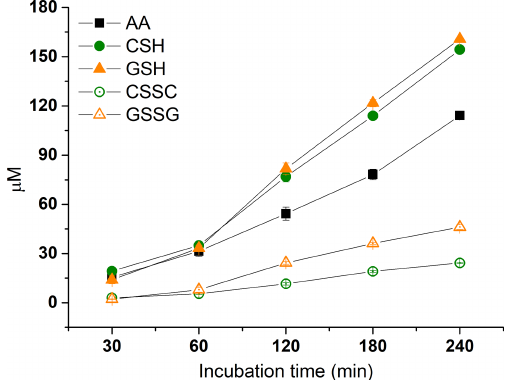
Figure 3. Time-dependent depletion of antioxidants AA, CSH, and GSH, and formation of oxidation products CSSC and GSSG in SELF-a containing 25µgmL − 1 of